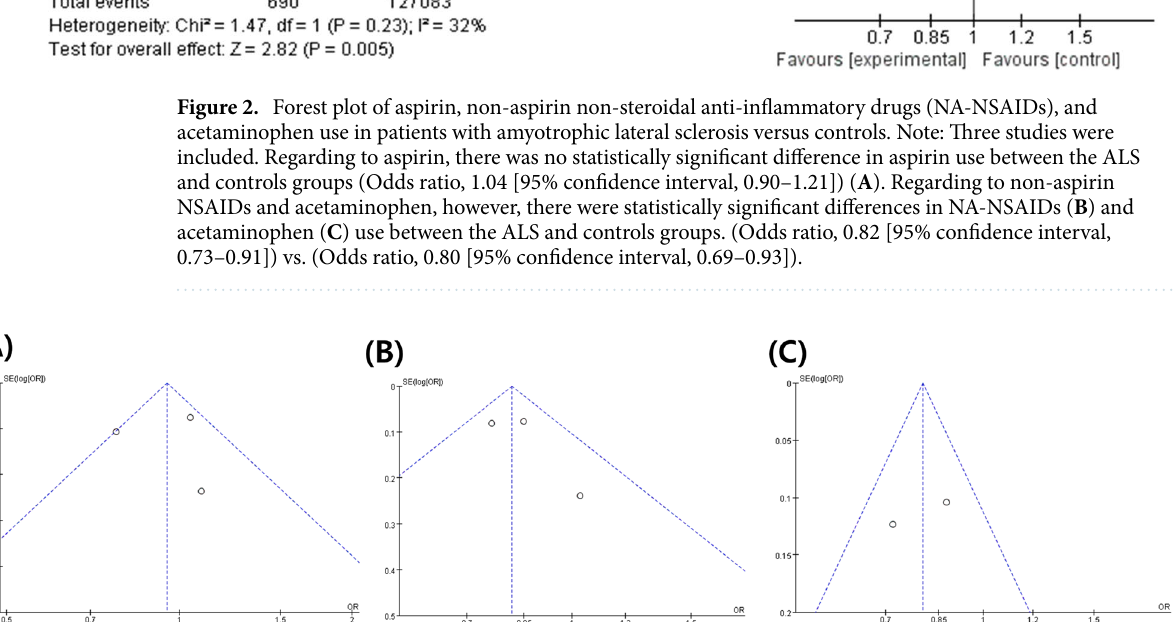
other hand is responsible for the transcriptional control of pro- and anti-inflammatory cytokines 18–20 . COX-2 activates the synthesis of prostaglandin and thromboxane, which in turn stimulates the secretion of inflamma- tory cytokines, such as tumor necrosis factor-alpha and interleukin-1, and induces the inflammatory pathway cytokines 18–20 . Non-aspirin NSAIDs inhibit the activity of COX-2, consequently inhibiting the inflammatory process by inhibiting prostaglandin synthesis 30,32–34 . This explains why non-aspirin NSAIDs would confer neu- roprotective effects which seem to suppress the development of ALS. Acetaminophen only confers weak effects on the inhibition of the action of COX-2 in humans 25 . Due to its minor anti-inflammatory effect, acetaminophen is not classified as an NSAID 25 . In a previous study, however,